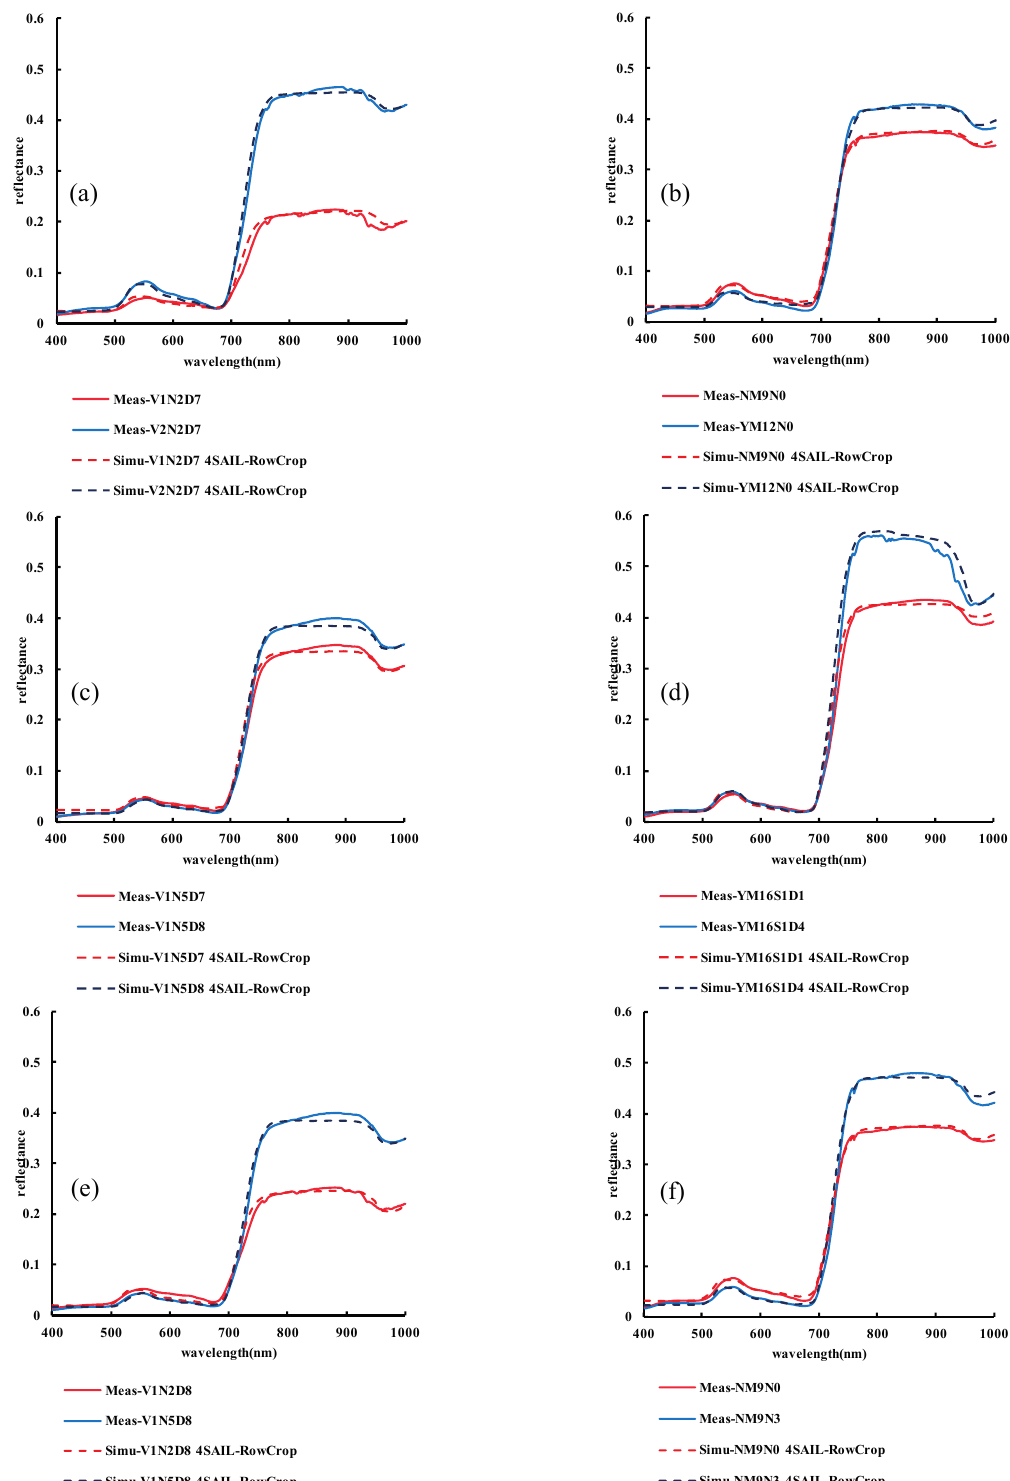
Figure 9. Measured (Meas) versus simulated (Simu) canopy NADIR spectral reflectance in different rice cultivars ( a ) and wheat cultivars ( b ), under different planting densities of rice ( c ) and wheat ( d ), under different nitrogen fertilization rates of rice ( e ) and wheat ( f